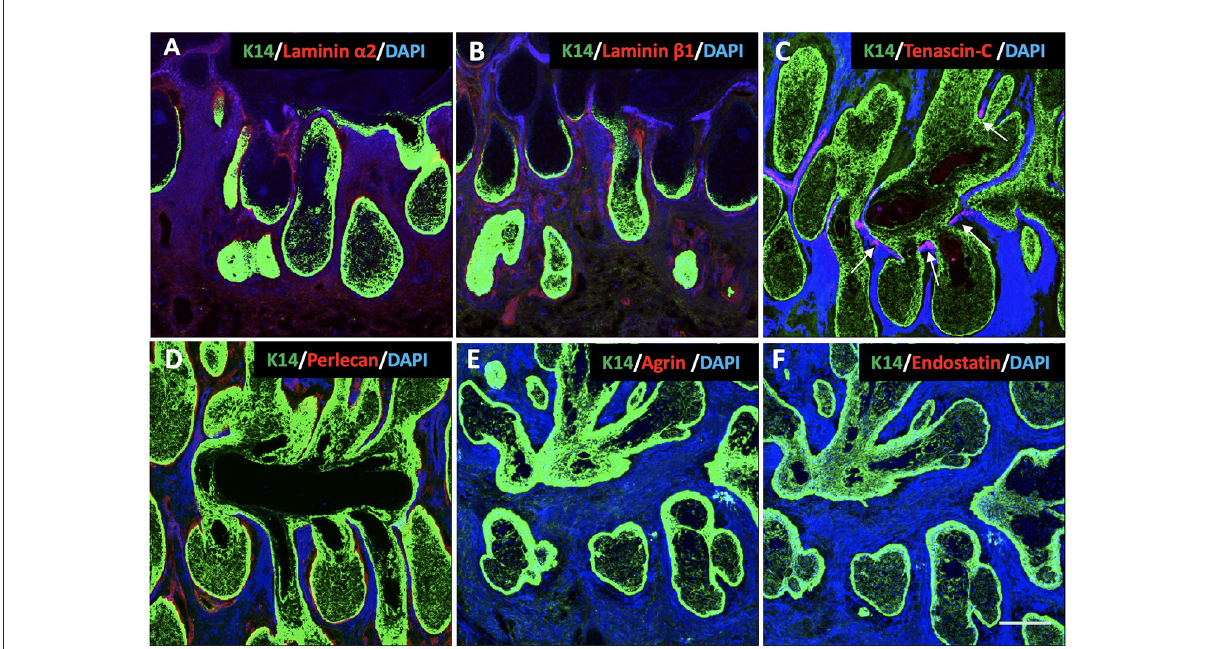
FIGURE3 Identification of K14 (green), glycoproteins (red) and proteoglycans (red) in the human Meibomian gland (MG). Nuclei were counterstained with 4’, 6-Diamidino-2-phenylindole (DAPI) in blue. Laminin α 2 (A) , laminin β 1 (B) and perlecan (D) stained positive surrounding the acini and the acinar/ductal junction, but not the region around the duct. Tenascin-C (C) was found specifically located at the junctions between the acini and the central duct (white arrows). The staining was negative for both agrin (E) and endostatin (F) in the human MG tissues. Scale bar = 100 µ M.